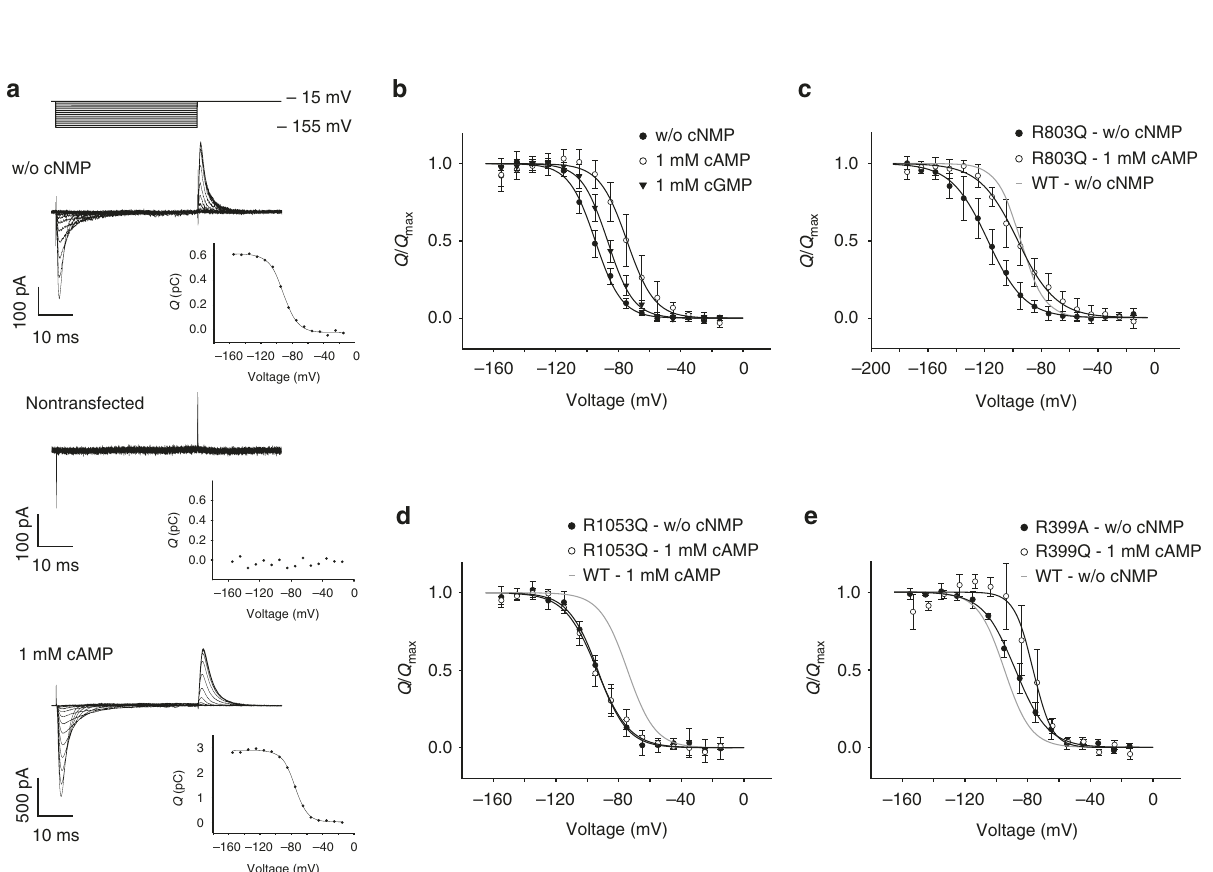
Fig. 2 Gating currents of Sp SLC9C1. Voltage protocol, gating currents, and charge – voltage ( Q / V ) relation. The solid curve in the Q / V relations (insets) represents a Boltzmann fi t. a Upper: wt Sp SLC9C1 without cNMP ( V 1/2 = − 91.4 mV, slope s = 9.2 mV). Middle: non-transfected CHO cells. Lower: wt Sp SLC9C1, 1 mM cAMP in the pipette solution ( V 1/2 = − 75.4 mV, s = 8.2 mV). b Q / Q max vs. V m relation. Mean± SD ( n = number of experiments) of V 1/2 and slope s was determined by a Boltzmann fi t (w/o cNMP: − 94.7 ± 2.9 mV, s = 8.5 ± 0.8 mV, q g = 3.1 e 0 , n = 6; cAMP: − 74.4 ± 6.4 mV, s = 8.8 ± 1.9 mV, q g = 2.9 e 0 , n = 7; cGMP: − 86.9 ± 3.0 mV, s = 8.3 ± 1.0 mV, q g = 3.1 e 0 , n = 7). c Replacing Arg803 in S4 by Gln (R803Q) shifted V 1/2 by − 24 mV and s by